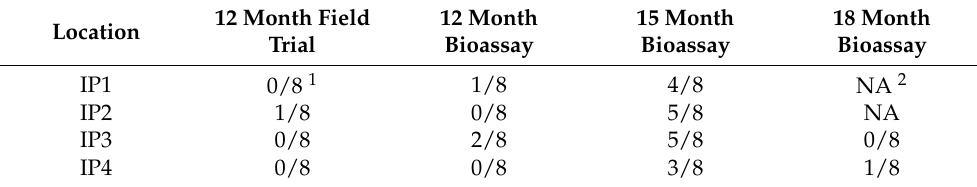
Table 1. In-field and pot trial (Bioassay) results of the four IPs for detection of CGMMV at 12, 15 and 18 months-post